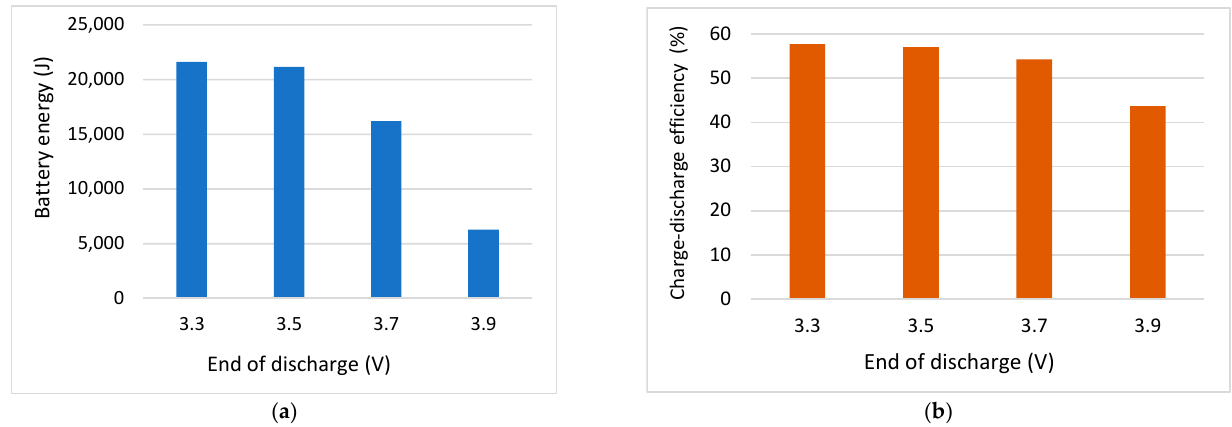
Figure 11. Energy consumption for different end of discharge values: ( a ) Energy consumed by a router; ( b ) Efficiency.